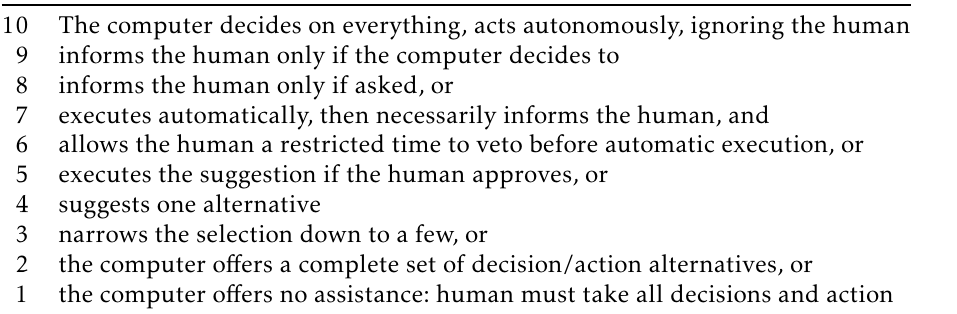
Table 6. Levels of automation scale (after Sheridan and Verplanck [37])